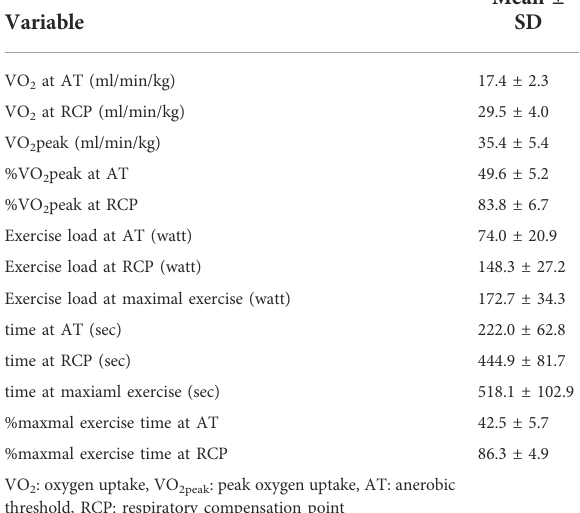
TABLE 1 Power output, oxygen uptake and exercise time during incremental